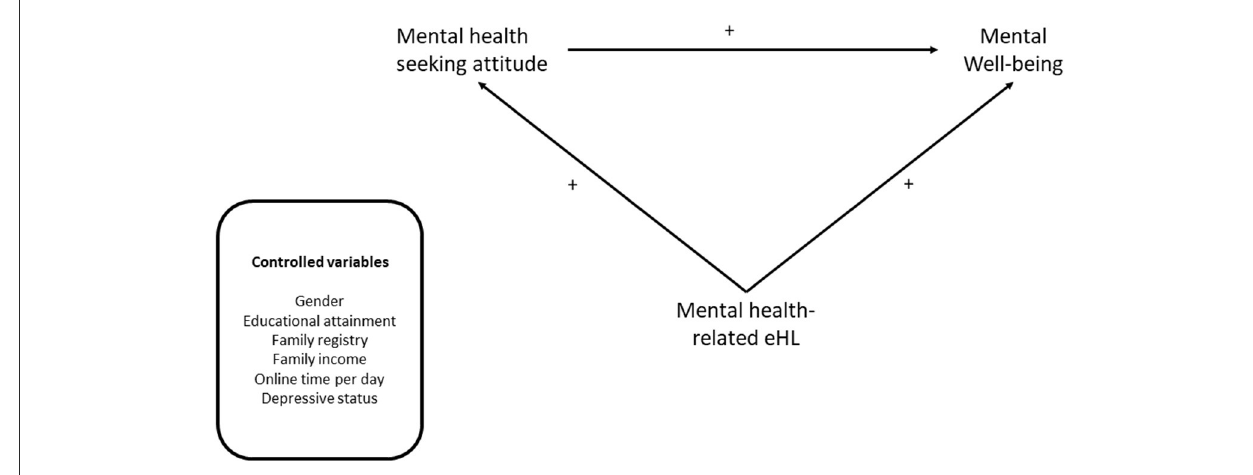
FIGURE1 The conceptual model of this study.